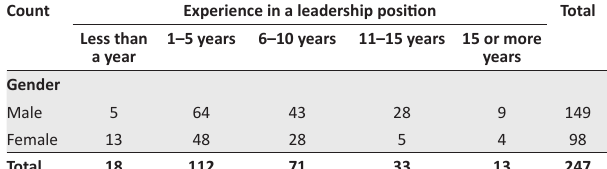
TABLE 2: Gender experience in a leadership position cross-tabulation.